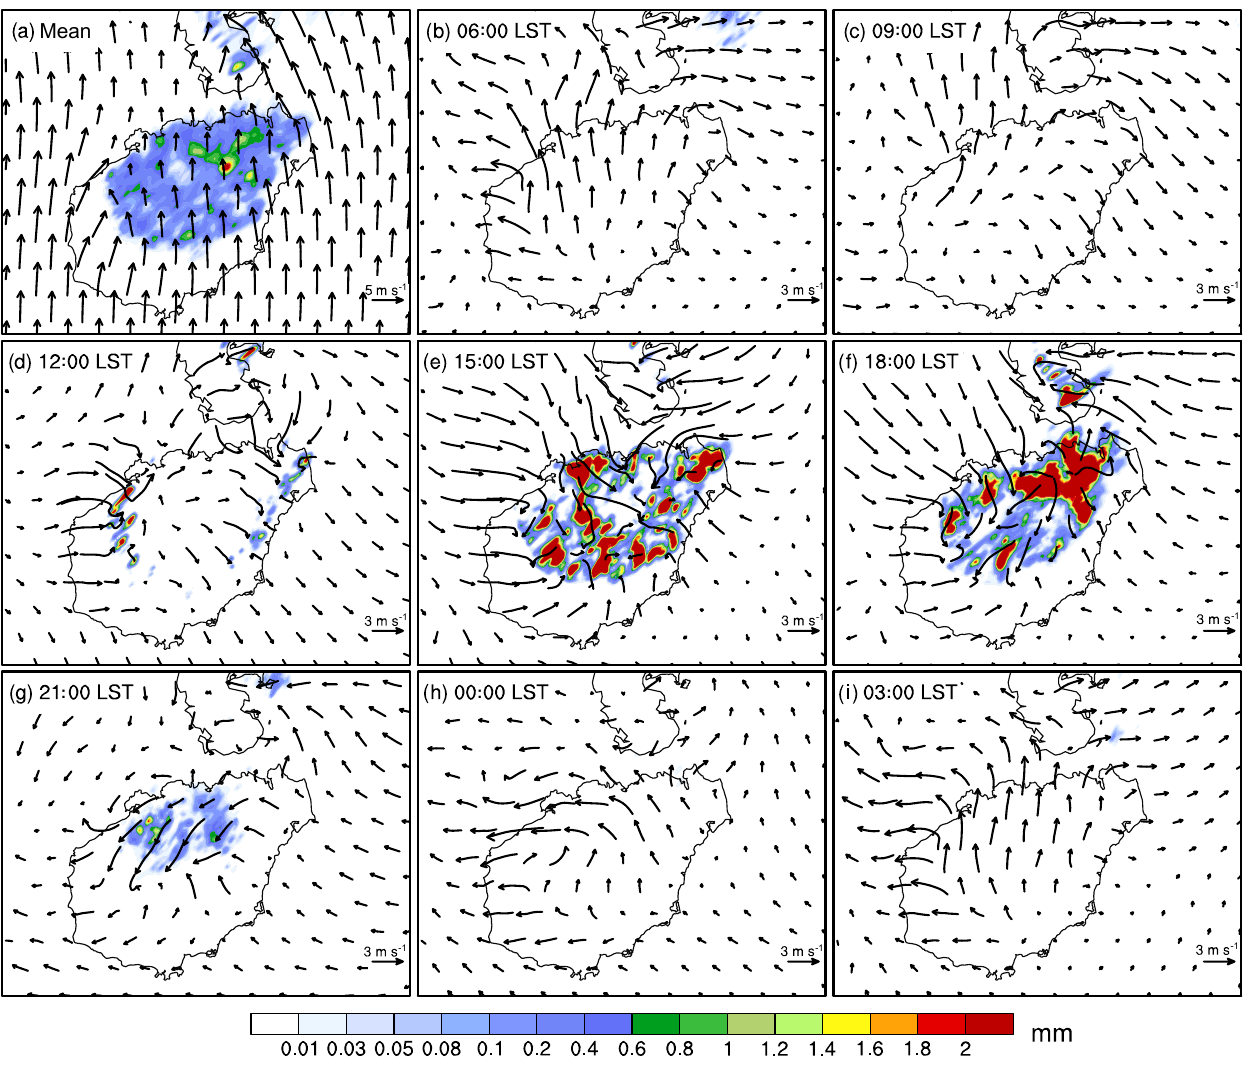
Figure 9. As in Fig. 8 but for the NoTER